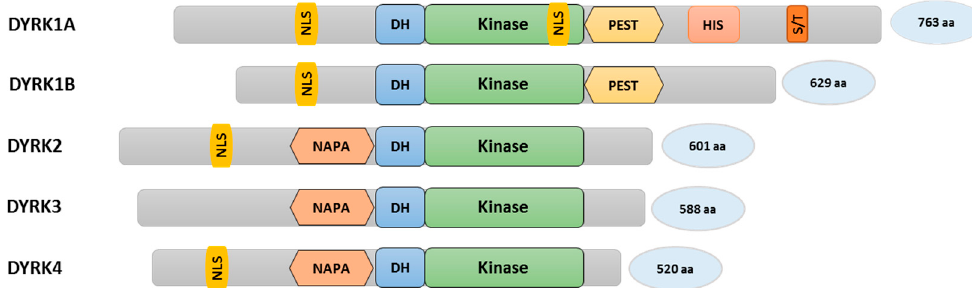
Figure 1. Schematic representation of the DYRK family of proteins: Distinct sequence motifs such as the nuclear localization signal (NLS); DYRK-homology box (DH); a motif rich in proline, glutamic acid, serine, and threonine residues (PEST); a poly-histidine stretch (HIS); a serine/threonine rich region (S/T); a N-terminal auto-phosphorylation accessory region (NAPA); and a conserved kinase domain comprising the structural and functional features of DYRKs.